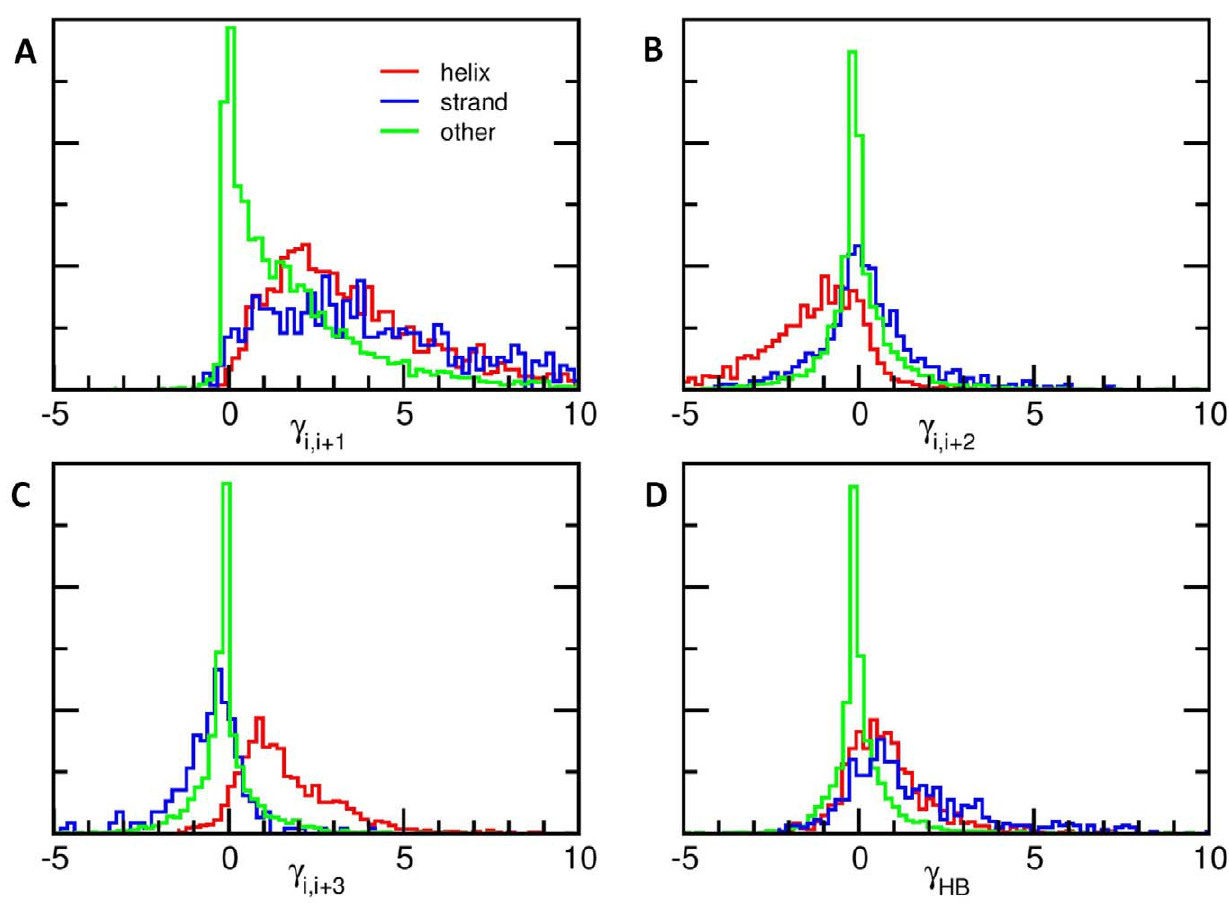
Figure 2. Force constant distributions vary with secondary structure and contact order. Panels A, B and C, respectively, show the force constant distributions for k =1, k =2 and k =3, colored by secondary structure. Red curves indicate force constants between residue pairs in which both amino acids are in a -helices (DSSP code H); blue curves are for force constants between residues in strands (DSSP codes E and B); and green curves are for all other interactions. In a -helices particularly, the k =1 interactions are strong and positive, the k =2 interactions are negative, and the k =3 interactions are again strong and positive. (D) Similar histograms for hydrogen bonding partners. The red curve shows k =4 interactions in a - helices, the blue curve shows force constants between hydrogen bonding partners in strands, and the green curve shows all other interactions